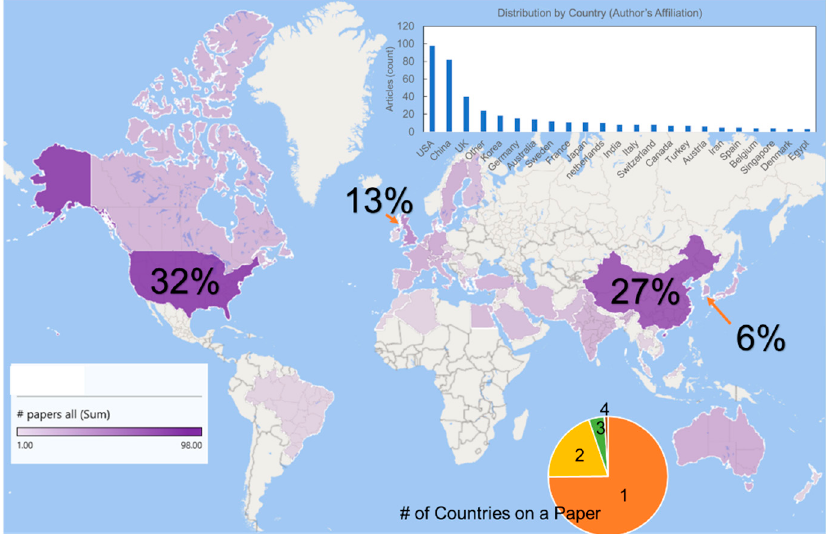
Figure 1. Global representation of 300 scientific articles published over the last 5 years.